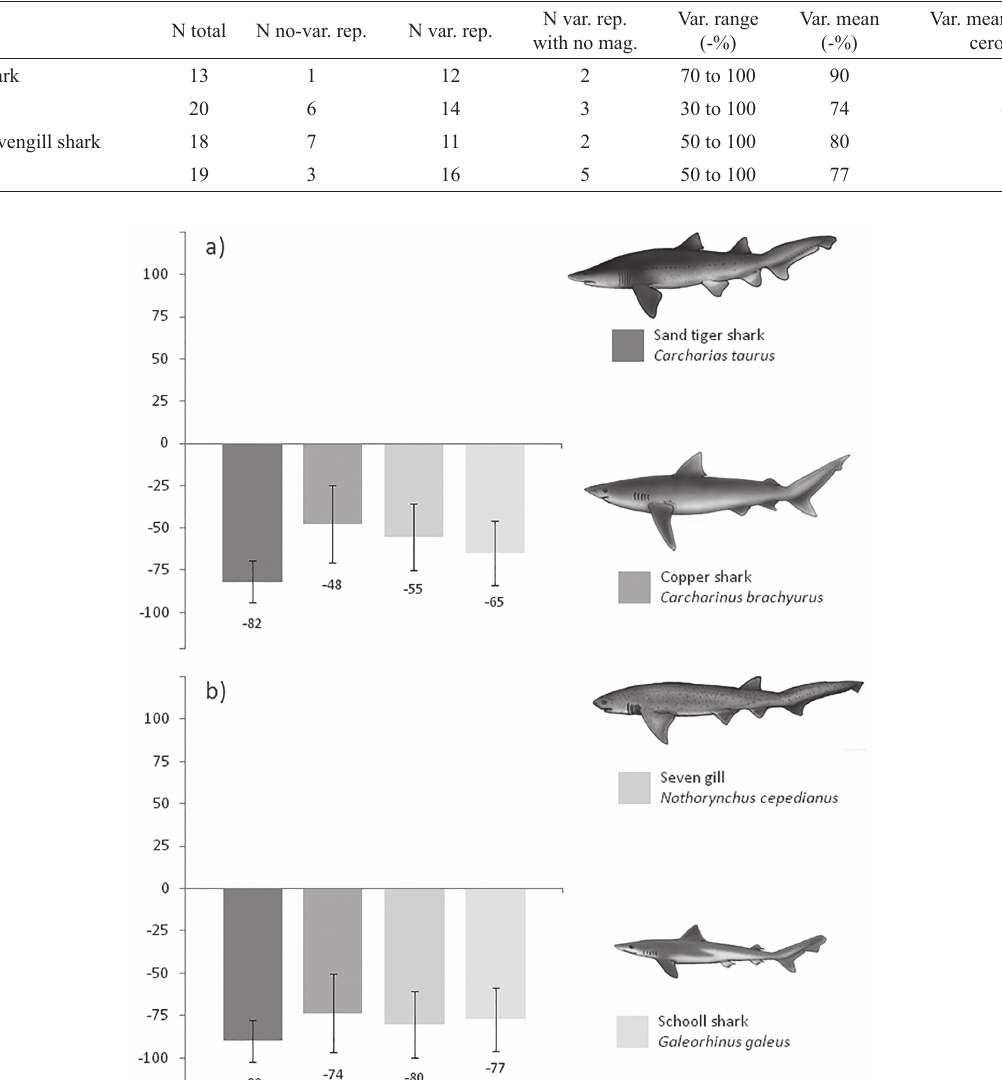
Fig. 2. Variation in abundance reported by fishermen between the beginning of their fishing activity and the last part. (a) With all reports considered and (b) with no abundance variation